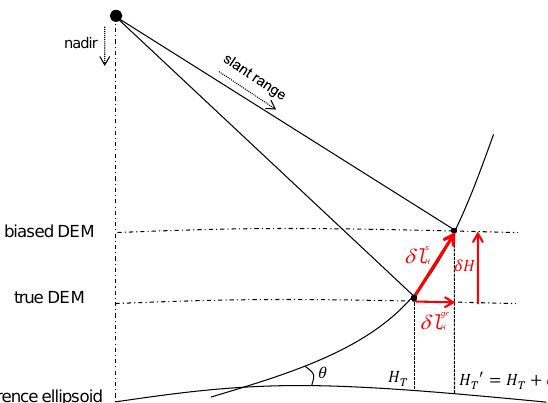
Figure 3. Depiction of height error δ H due to unknown DEM error at the reference point and its effect on geocoded coordinates. It can be seen that this error causes a shift in the cross-range direction δ l s which is decomposed into an offset in ground range δ l gr